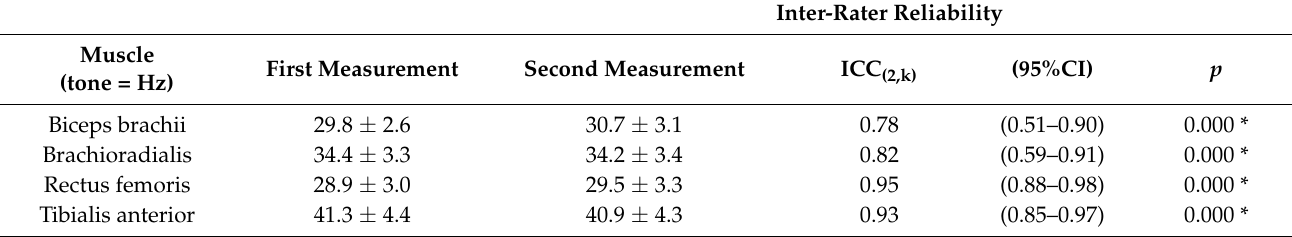
Table 4. Inter-rater reliability of the myotonometer in measurements of muscle tone. Inter-Rater Reliability